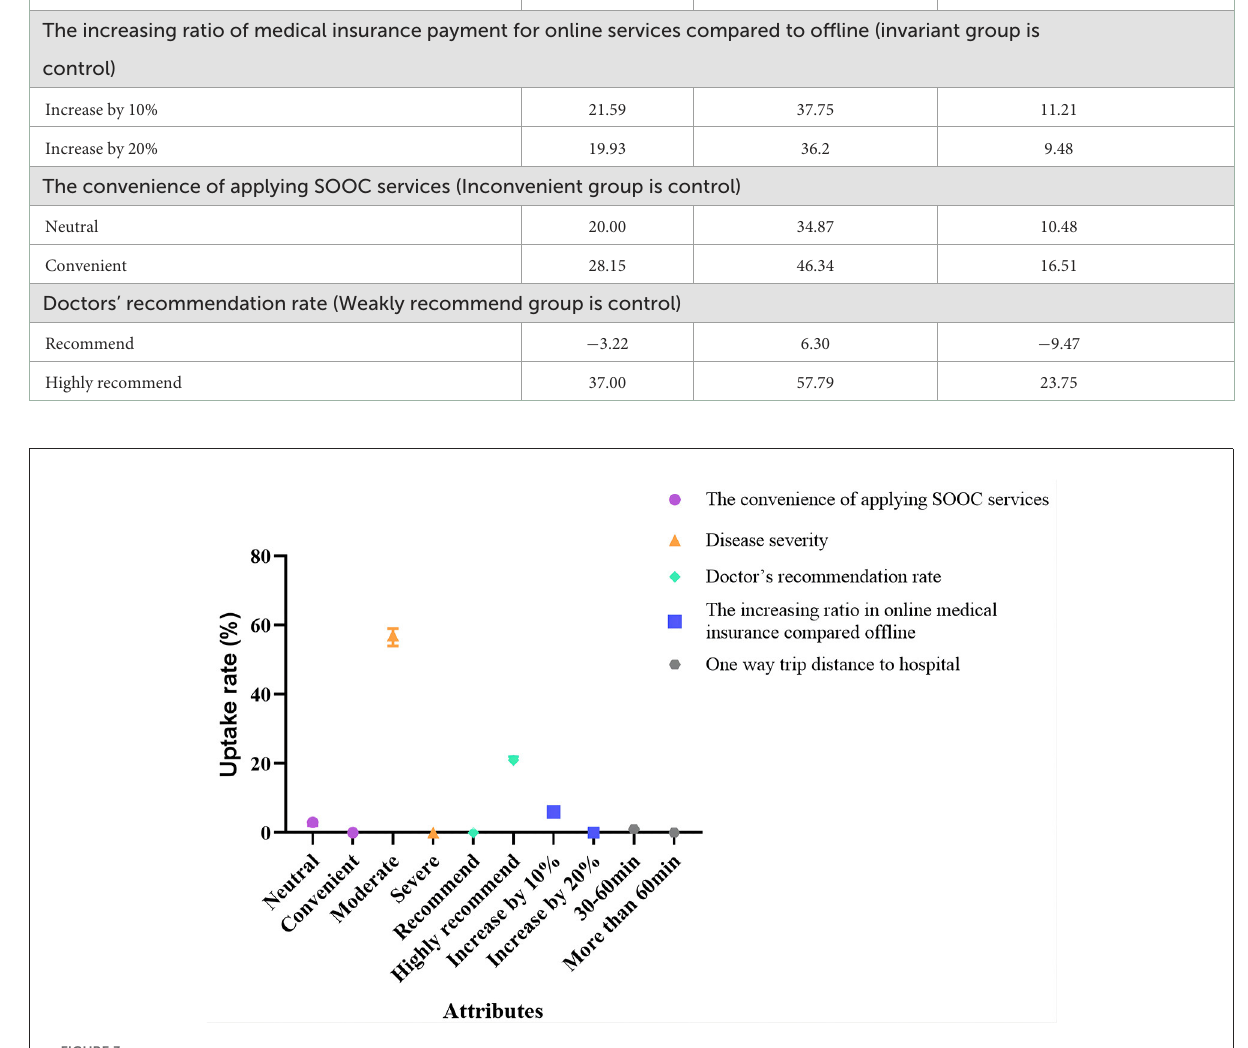
FIGURE3 Changes in the probability of